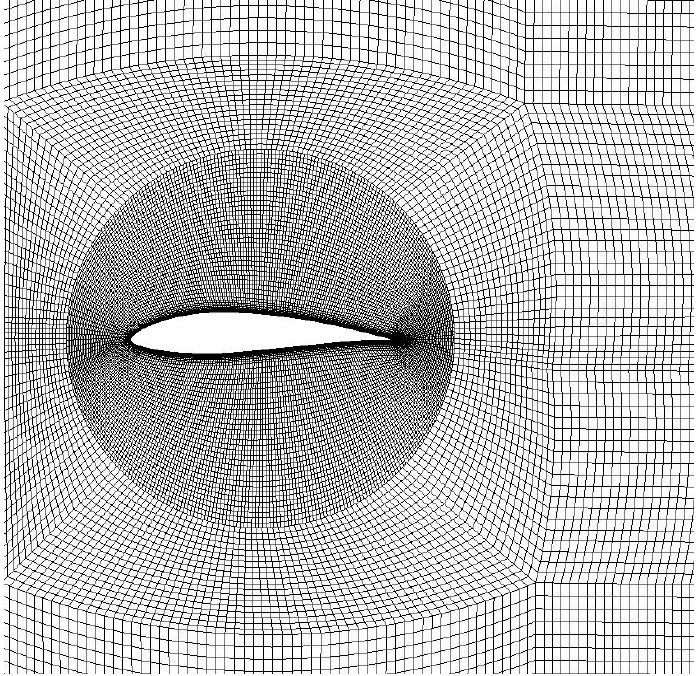
Figure 3. Detail view of a typical grid.